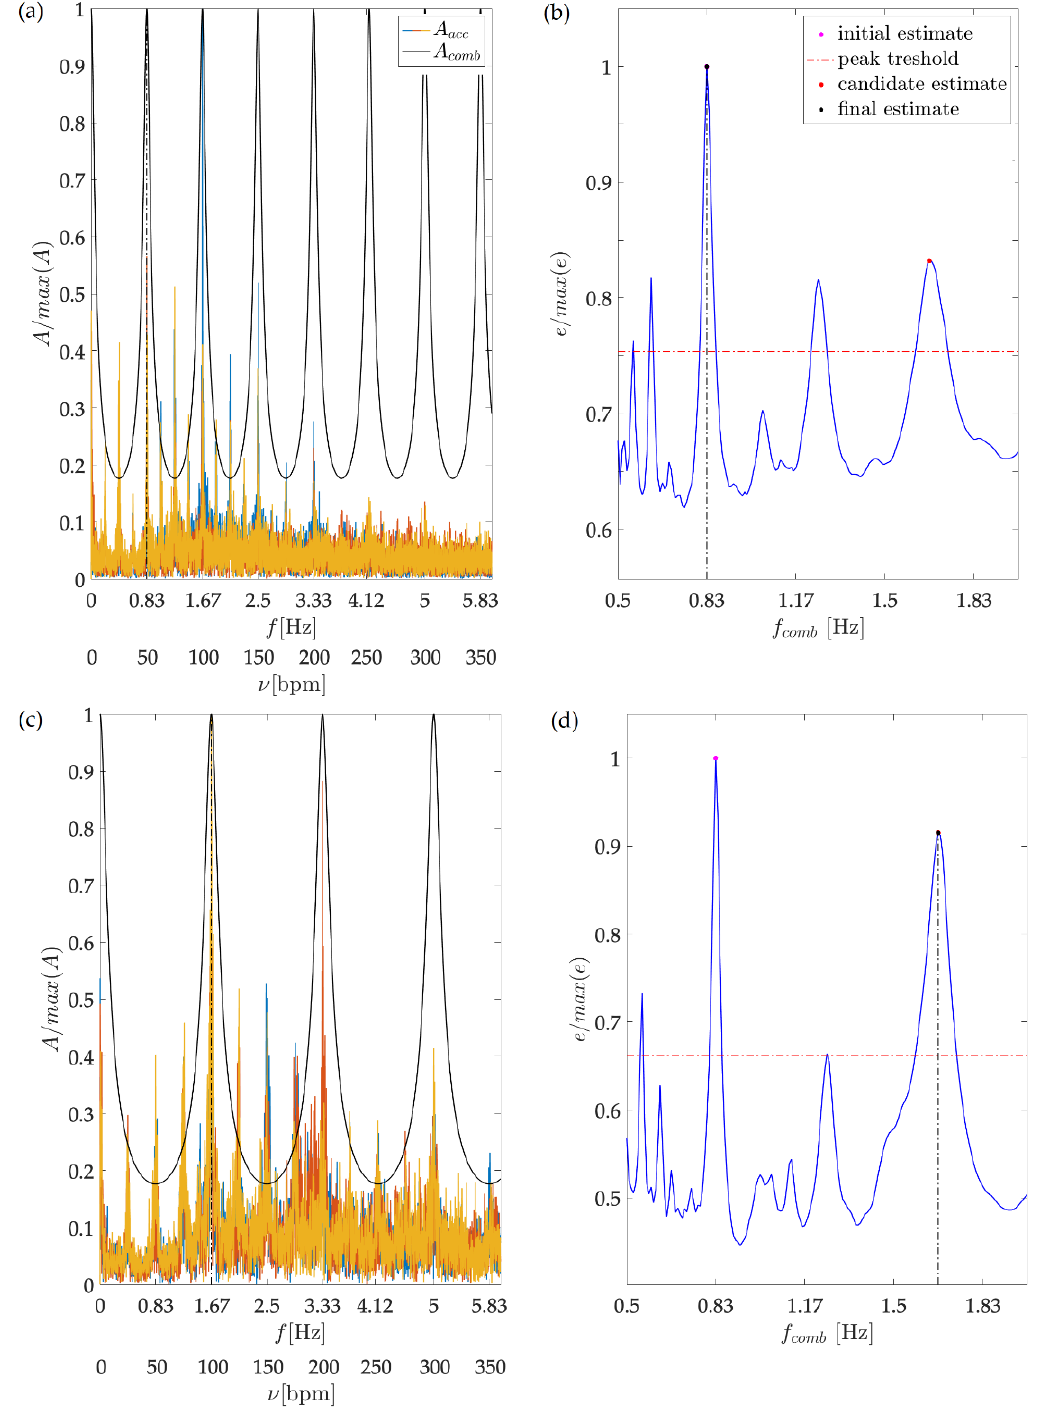
Figure 3. Overall dance tempo estimation. The first and second row refer to the recreational dancer’s 100 and 200 bpm testing sequences, respectively. Images ( a , c ) depict in colour the 3D acceleration amplitude frequency spectrum. For both examples, the spectrum has a clearly distinguishable peak at the respective step frequency, ( a ) 0.83 Hz for the 100 bpm tempo and ( c ) 1.67 Hz for the 200 bpm tempo). Depicted in black colour is the magnitude response of the tuned comb filter. Both plots are normalized to fit into to [0,1] range. Images ( b , d ) present the output energy, calculated for the entire range of comb filters frequencies together with step frequency estimates.